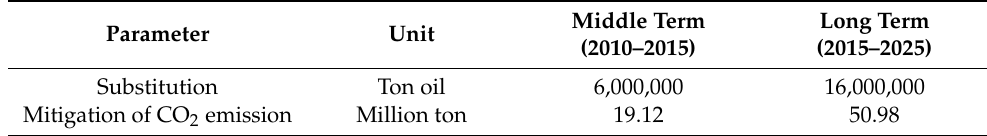
Table 13. The possible CO 2 emissions’ mitigation generated from biodiesel